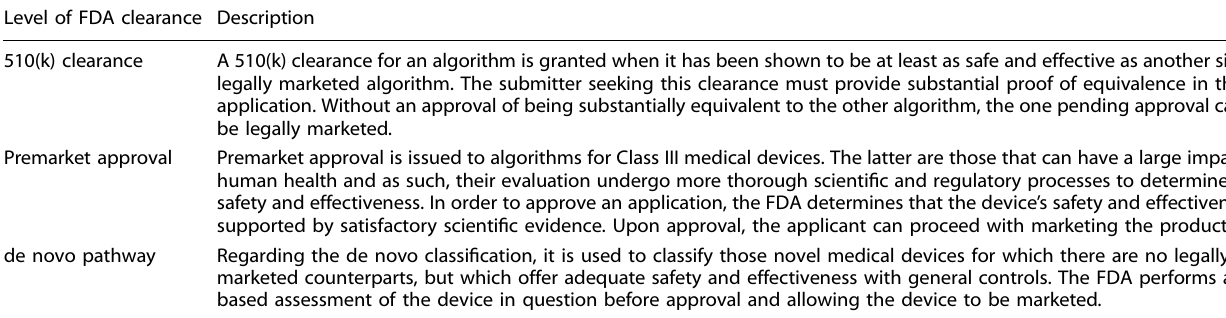
Table 1. Descriptions of the types of FDA approvals for AI/ML-based medical